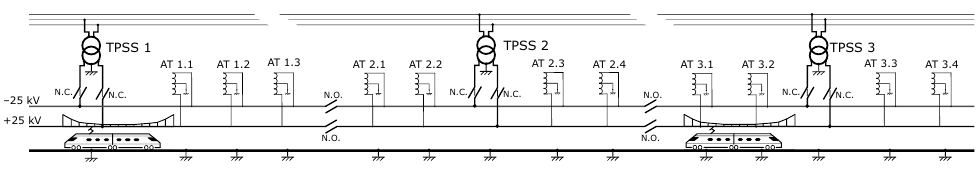
Figure 18. Single-line diagram of case study #2, a 2 × 25 kV